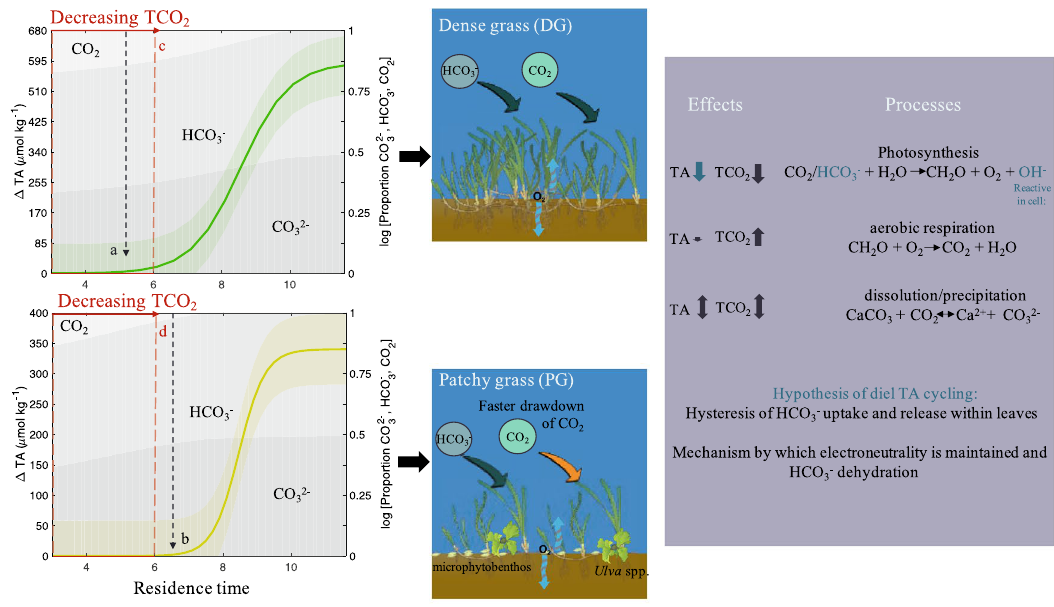
Figure 6. Conceptual model plots of ΔTA as a function of residence time and the concomitant change in carbonate chemistry speciation (shaded in grey) for dense grass (green) and patchy grass (yellow) based on measurements presented in Figs. 3 and 4. Dashed lines on plots indicate specific time points at which TA decreases: ( a ) TA begins to decrease at 5 h when [CO 2 ] is still moderate, ( b ) TA begins to decrease at 6.5 h when residence time TCO 2 decreases at rate of − 205 µmol kg −1 h −1 . Stoichiometric equations and the effects on TA are shown in purple box with hypothesized processes modulating TA based on this study in dark blue